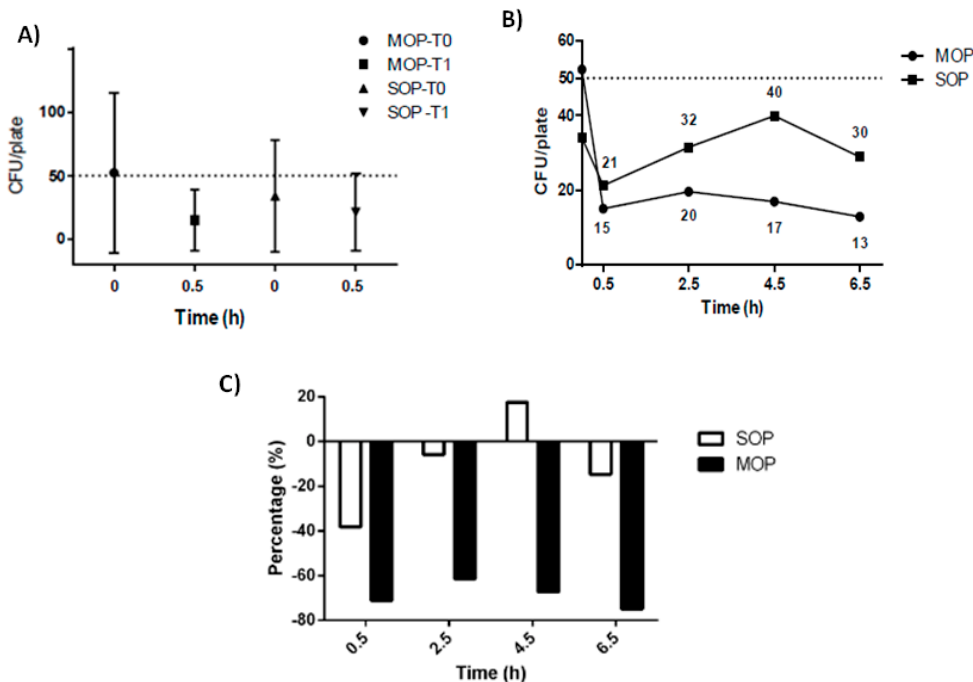
Figure 2. Trend of the Total Viable Counts (TVCs) and percentage reduction of the values before and after the application of the cleaning and disinfection procedures on non-electromedical surfaces: ( A ) Average TVCs before and after 0.5 h the two procedures ( B ) Temporal trend of TVCs during the 6.5 h of sampling ( C ) Percentage reductions of the TVCs. Note: The dashed line represents the targeted bacterial burden proposed by the Italian Workers Compensation Authority (TVC < 50 CFU/plate, plate equal to 24 cm 2 ).